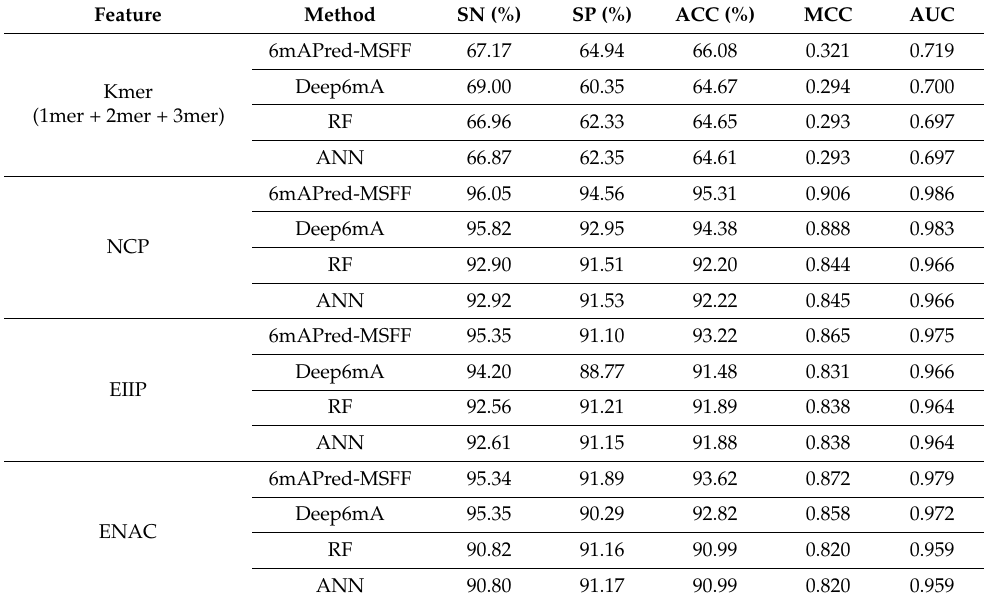
Table 5. Performance comparison of methods based on the 6mA-rice-Lv dataset under different feature